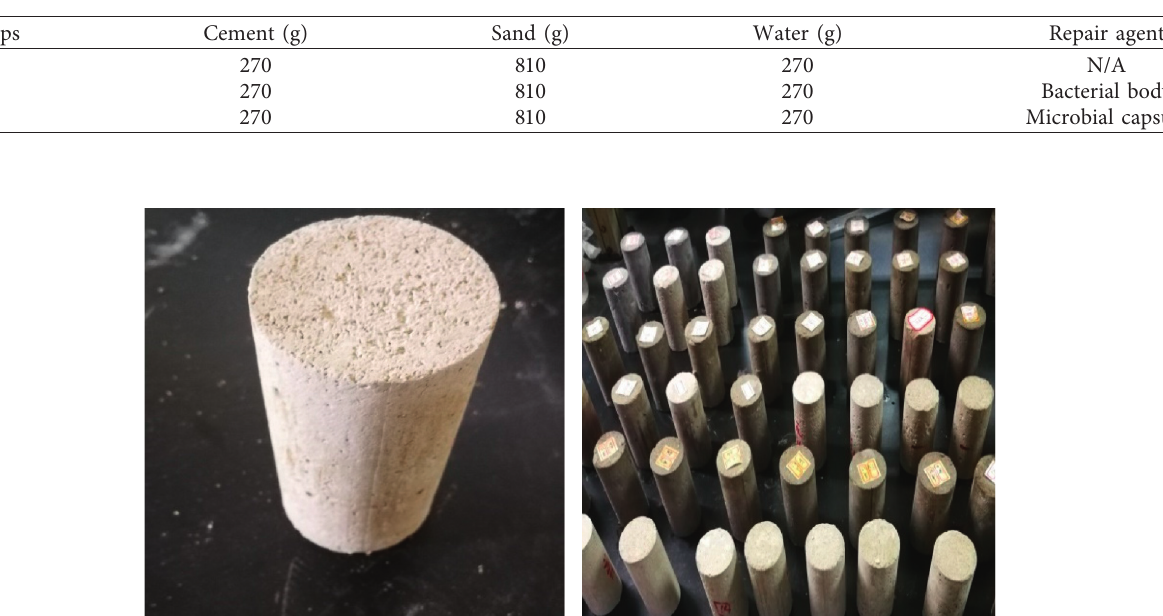
Figure 4: The preparing flowchart. Table 4: Material ratios.